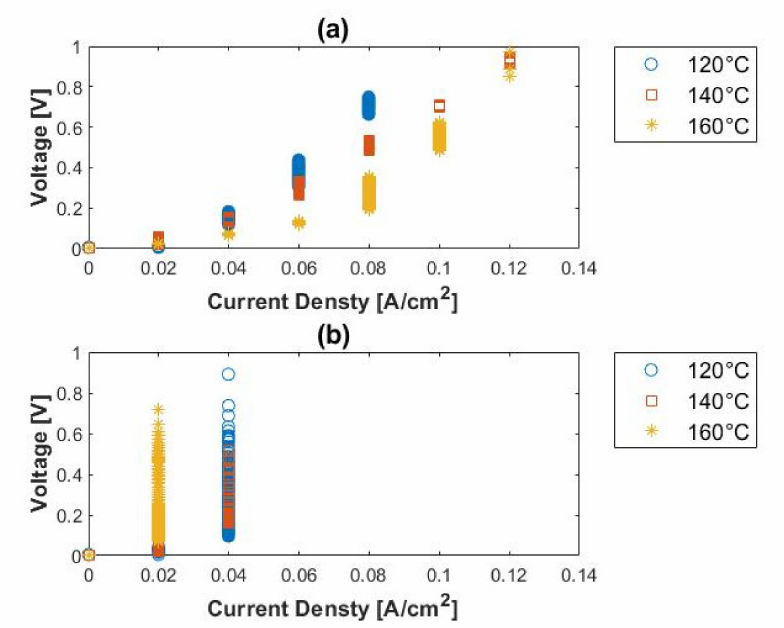
Figure 14. Polarization curves for ( a ) 1500 ppm, ( b ) 3000 ppm ammonia, balance hydrogen (hydrogen flow rate = 100 mL n /min, 1 atm).